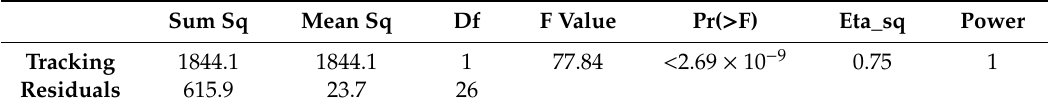
Table 2. Type III ANOVA for Duration of Run for Females.